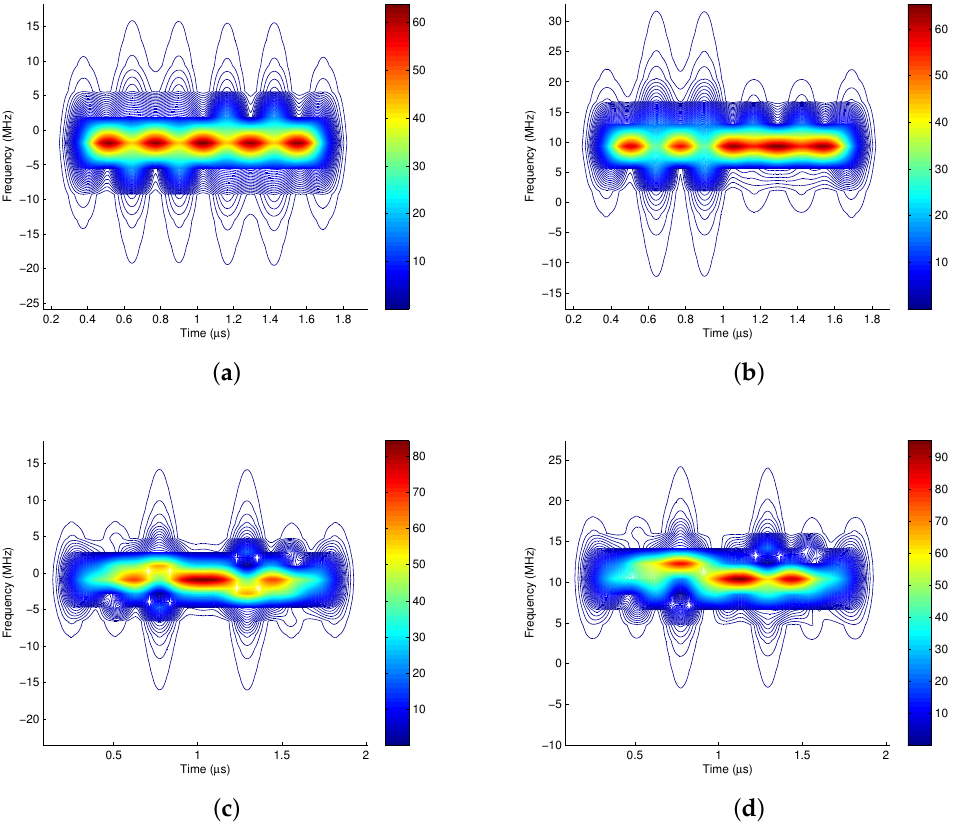
Figure 8. Realizing time-frequency equivalent analysis of baseband and RF by controlling the window length. ( a ) Baseband complex signal, L h = 30; ( b ) RF signal, L h = 30; ( c ) Baseband complex signal, L h = 60; ( d ) RF signal, L h =